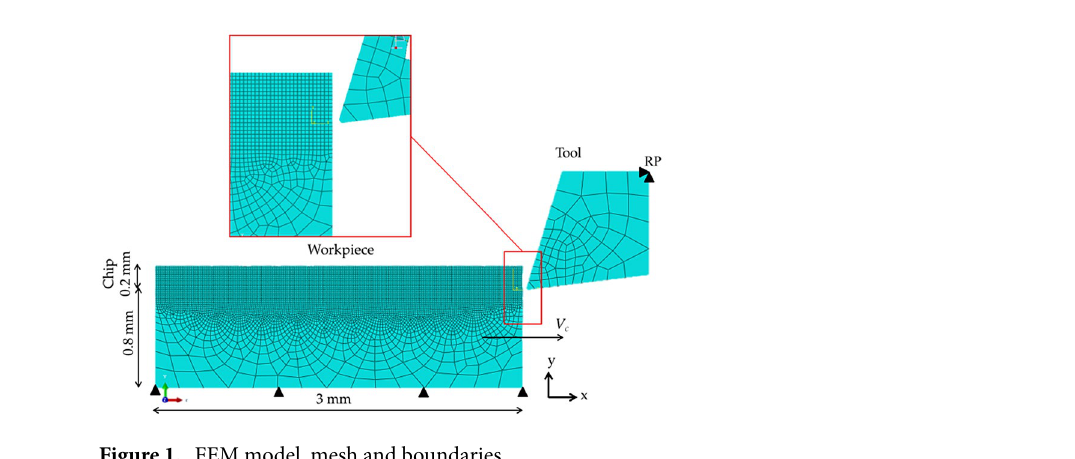
Figure 1. FEM model, mesh and